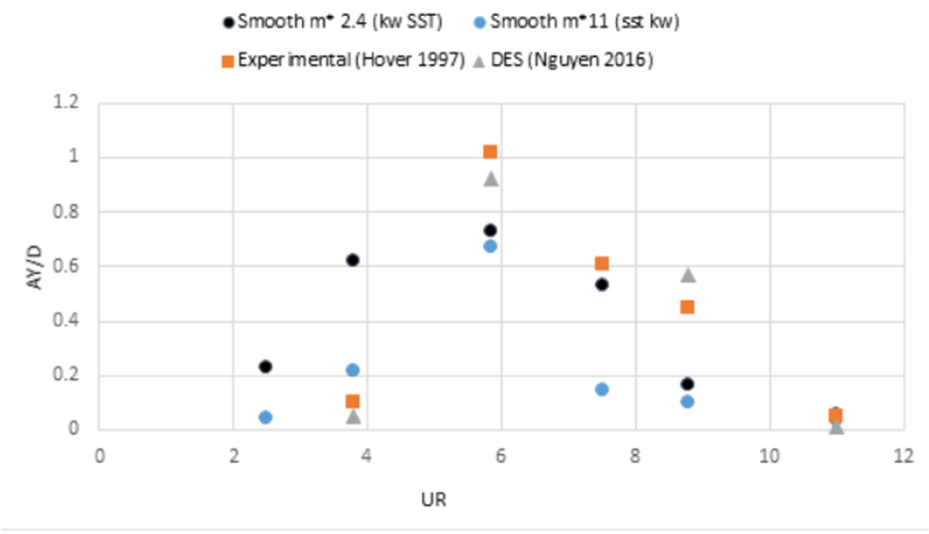
Figure 6. Comparison of amplitude response for cylinders at (m* = 11 & m* = 2.4).